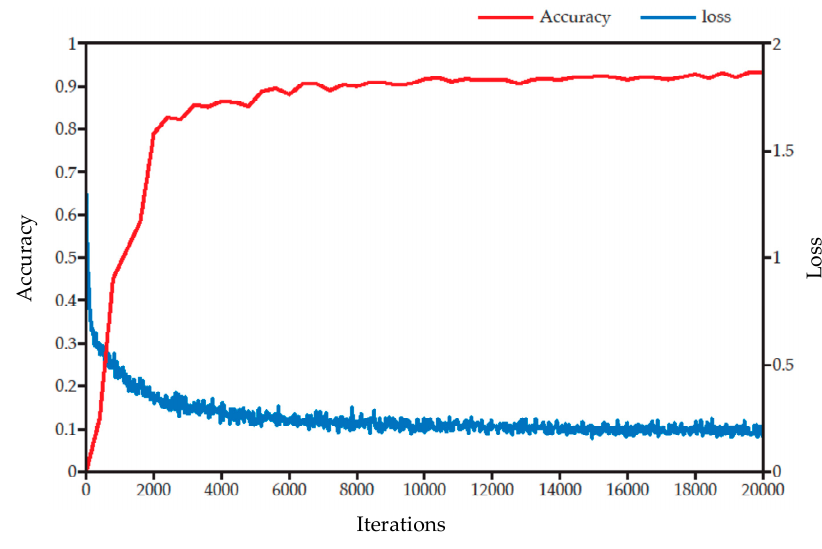
Figure 12. The training accuracy and the loss of the final model.